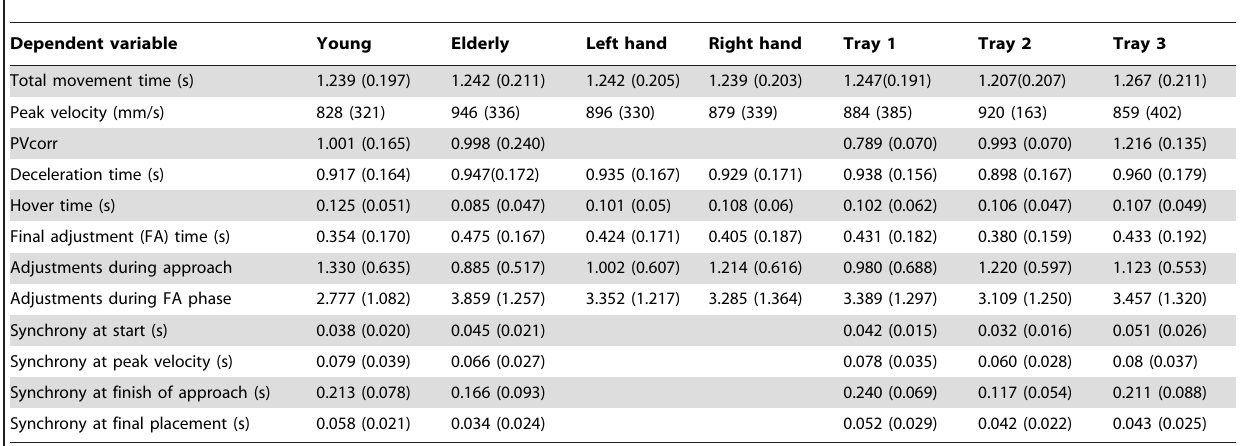
Table 1. The means (and standard deviations) for all dependent